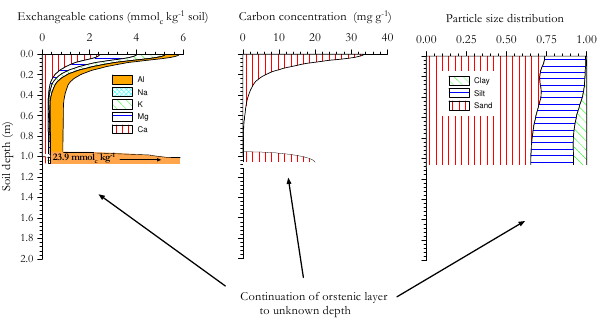
Fig. 15 Fig. 15. Profiles of exchangeable cations, soil carbon and texture for a Haplic Fluvisol (Orthodystric) in Ecuador